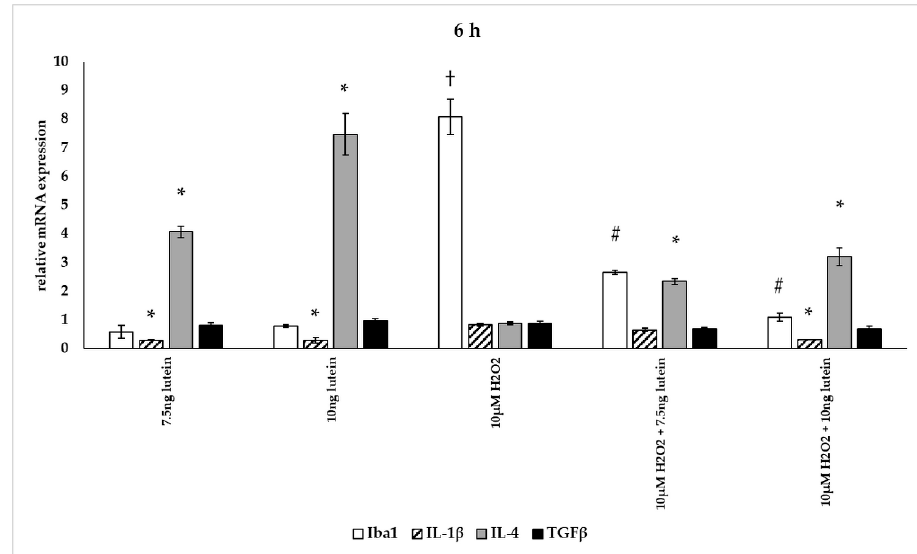
Figure 12. Effects of lutein and H 2 O 2 on Iba1, IL-1 β , IL-4 and TGF β mRNA expression at 6 h. The columns represent the mean values, and error bars indicate the standard deviation (SD) of three independent experiments ( n = 3), each performed in triplicate, and are presented relative to own control cells. * indicates statistical significance of lutein treatments versus controls; † indicates statistical significance of H 2 O 2 -treated cells compared to controls; # indicates statistical significance of combined (lutein with H 2 O 2 ) treatments compared to H 2 O 2 treatments; the level of significance was p < 0.05. Real-time PCR was performed with the SYBR green protocol using gene-specific primers. β -actin was used as house-keeping gene for the normalization. The relative expression of controls was regarded as 1.